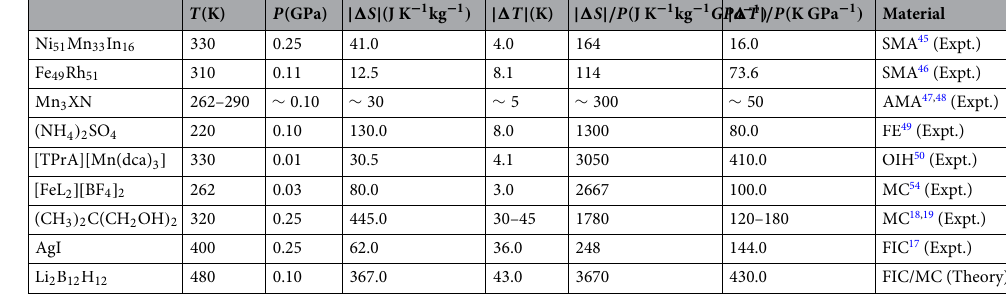
1 1 1 1 kg − ) and colossal ( | (cid:31) S | ∼ 100 J K − kg − ) barocaloric